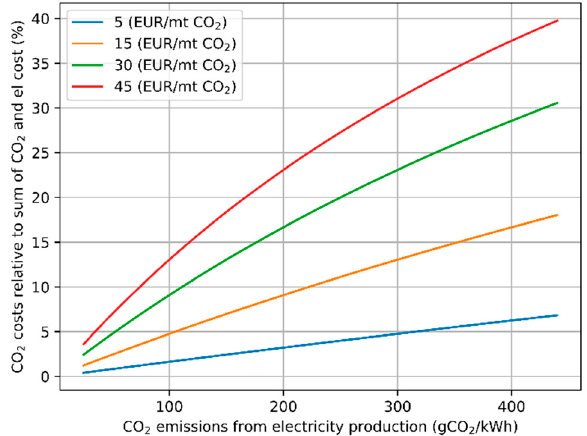
Figure 6. CO 2 cost relative to total cost of electricity assuming typical Norwegian electricity costs at 0.03